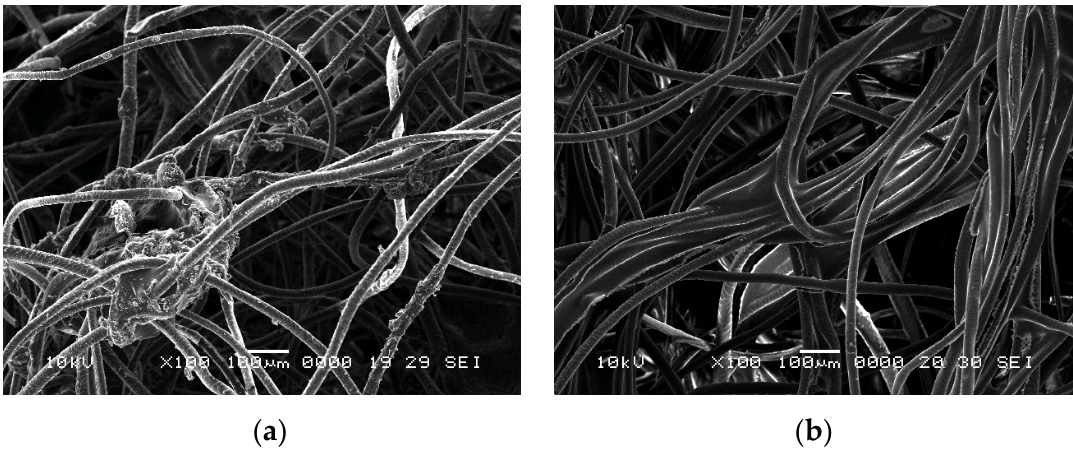
Figure 12. SEM images of wool-binder samples at ×100 magnification: ( a ) P3; ( b ) P13.